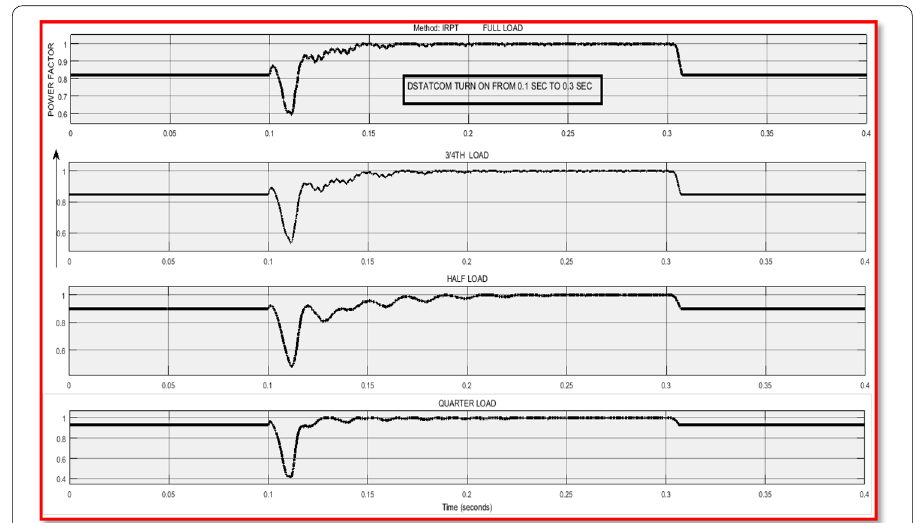
Fig. 20 Power Factor of a system without controller (duration from 0 to 0.1 s & 0.3 to 0.4 s) and with controller (duration from 0.1 to 0.3 s)